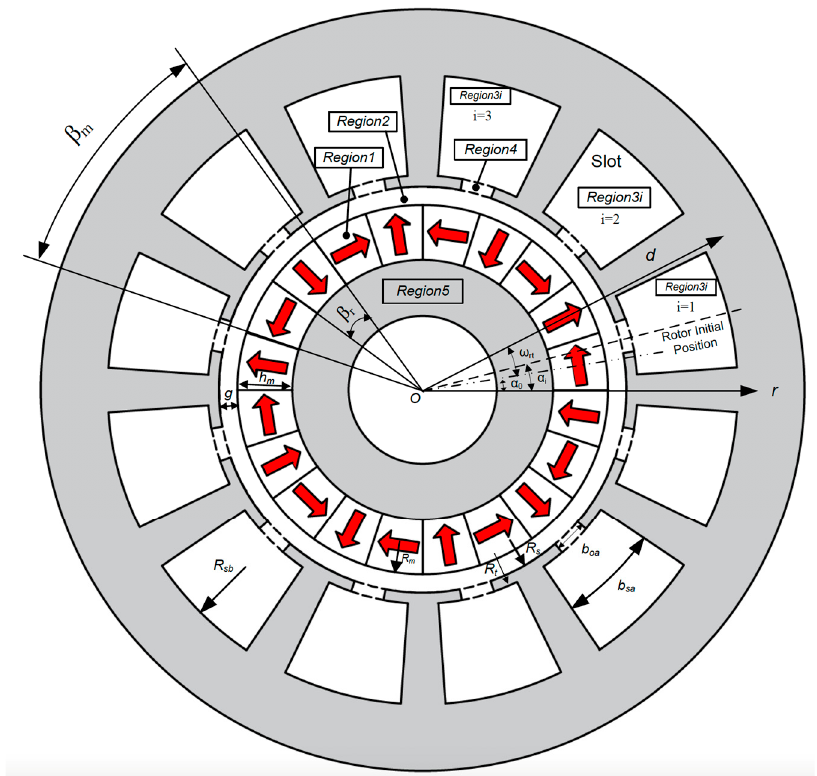
Figure 1. Symbols and Regions of Subdomain Model with Tooth-tips.